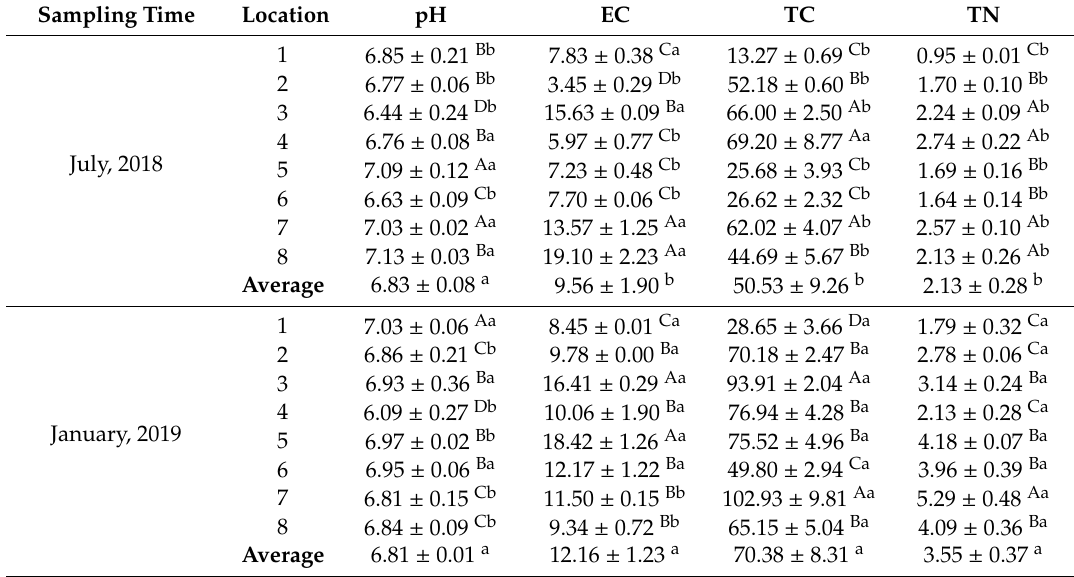
Table 1. Soil pH, electrical conductivity (EC), total carbon and total nitrogen in the investigated mangrove soils 1